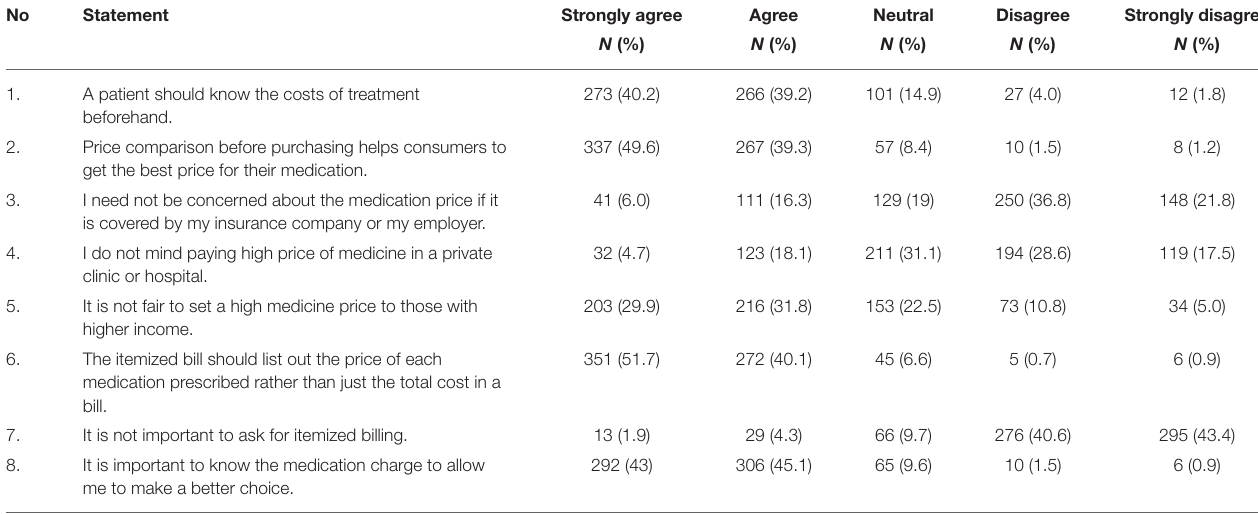
TABLE 3 | Respondents’ attitudes on medicine price transparency practice in private healthcare setting in